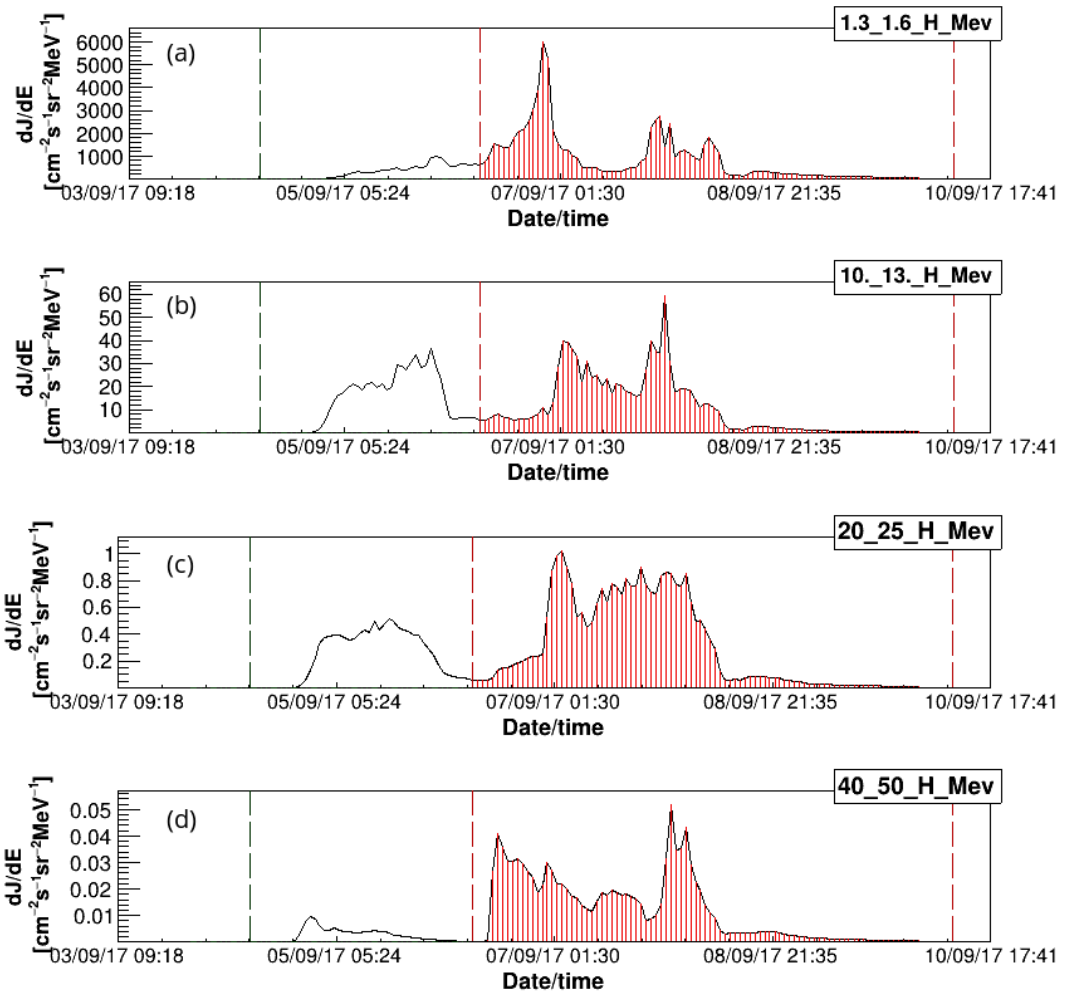
Figure 1. Hourly time series (UT) for several different proton channels from SOHO/ERNE (( a ) 1.3–1.6 MeV, ( b ) 10–13 MeV, ( c ) 20–25 MeV, ( d ) 40–50 MeV channels’ energy bands) for September 2017. Integration interval for spectral fluence is indicated with red vertical dashed lines.